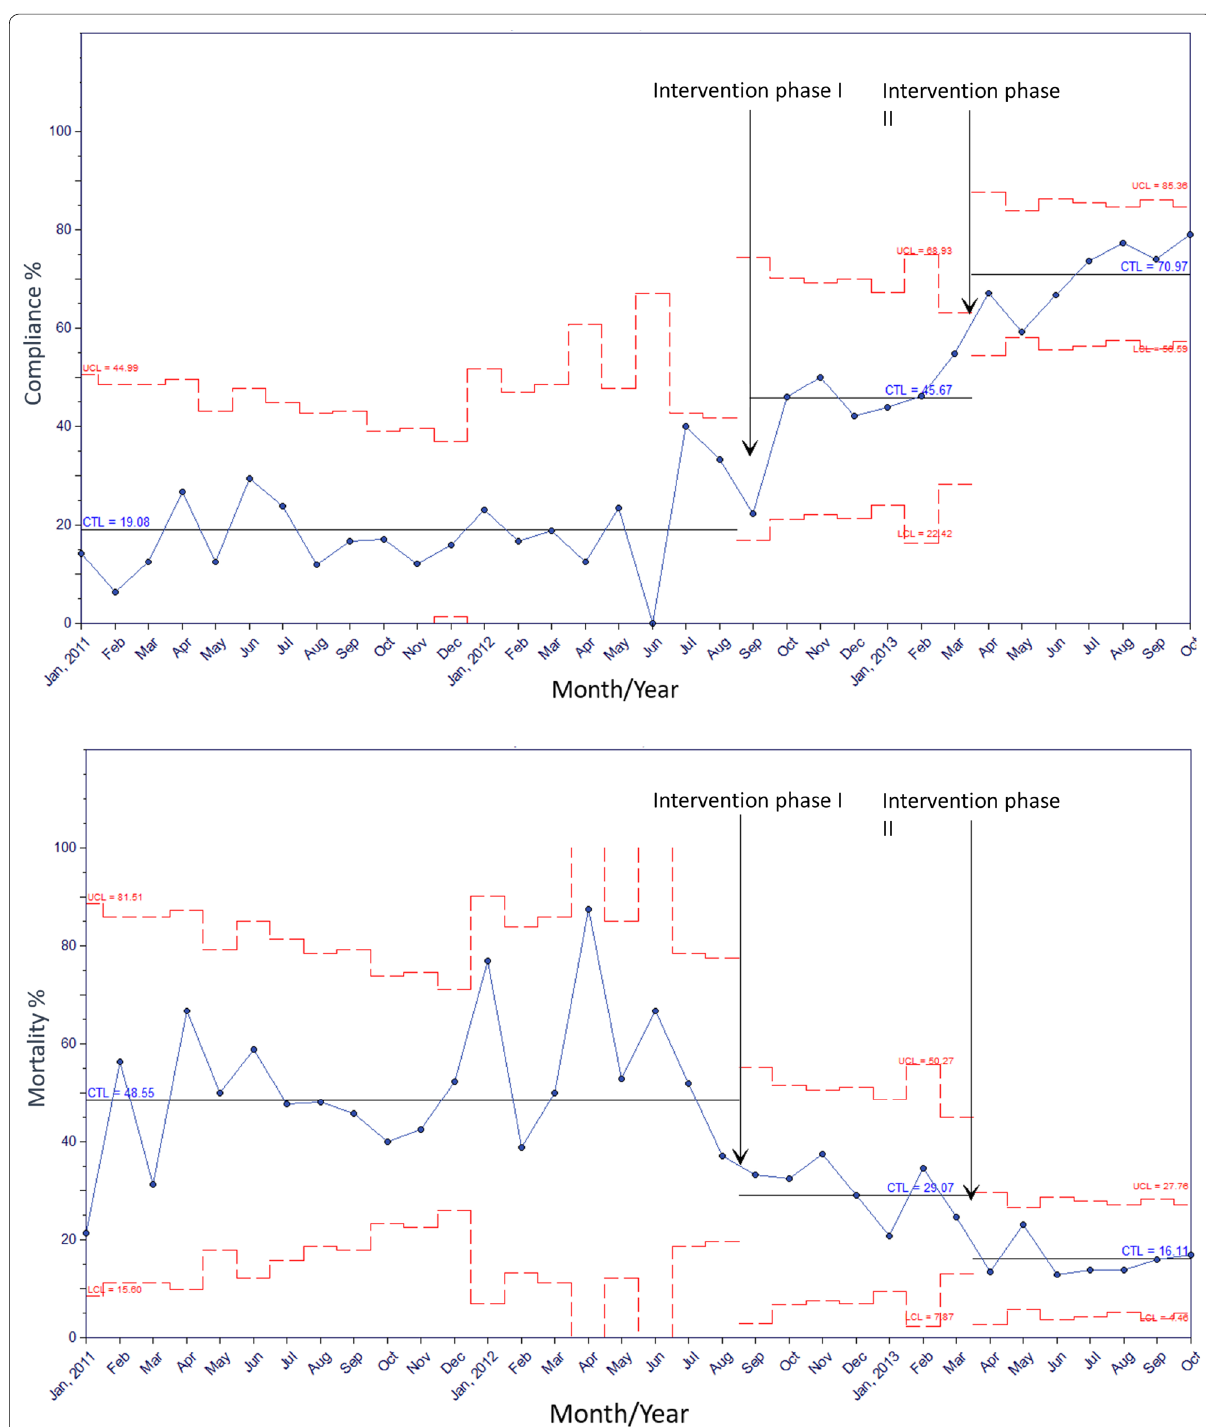
Fig. 1 Control chart with upper and lower control limits of the overall compliance with the resuscitation bundle and the mortality in the three phases. The two arrows on the chart show the time of initiation of the intervention phases I and